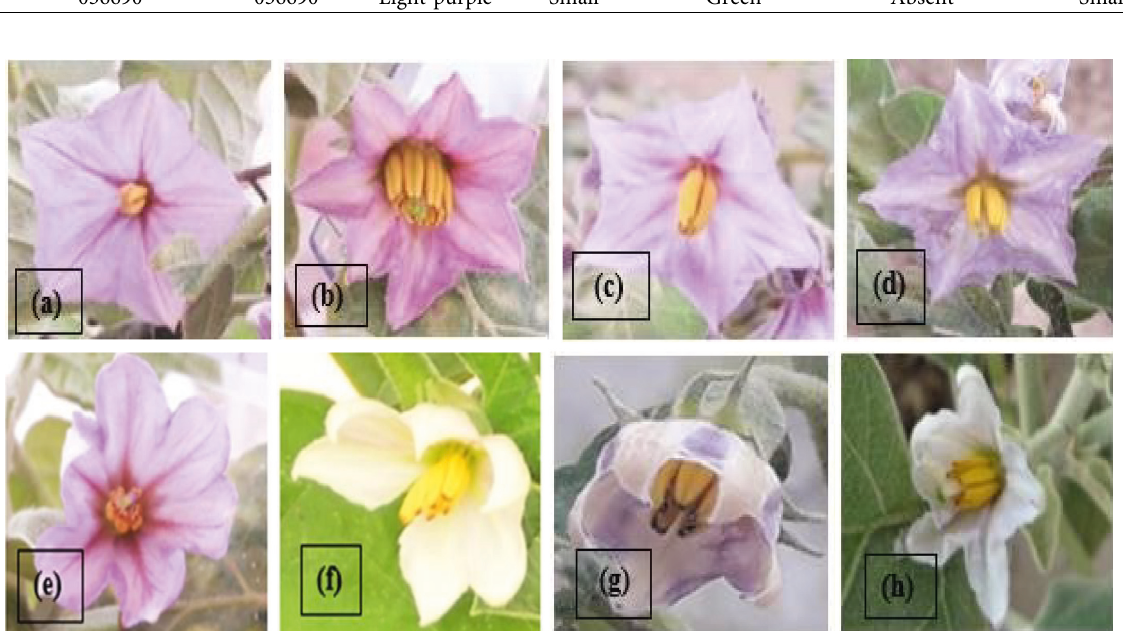
Figure 2: Morphological variation in flower color, number of corollas, and corolla margin among 22 eggplant accessions. (a) Eggplant variety PI-321018 having a light purple colored flower with 5 winged petals. (b) Eggplant variety BARI-1 having a dark purple colored flower with 7 pointed petals. (c) Eggplant variety PI-381288-A having a light purple colored flower with 5 pointed petals. (d) Eggplant variety PI371849 having a light purple colored flower with 5 pointed petals. (e) Eggplant variety PI-606711 having a light purple colored flower with 6 rounded petals. (f) Eggplant variety PI-251506 having a white colored flower with 6 pointed petals. (g) Eggplant variety Xiangzue-6 371849 having a light purple colored flower with 5 pointed petals. (h) Eggplant variety white egg having a white colored flower with 5 pointed petals.